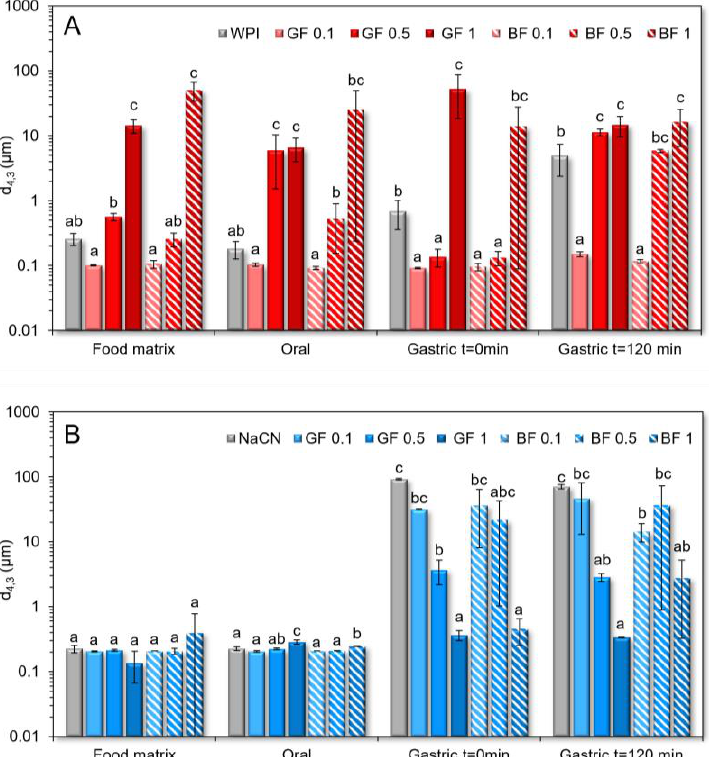
Figure 4. Changes in the protein aggregate particle size as they occurred throughout the simulated in vitro oro-gastrointestinal processing of the WPI-( A ) and NaCN-( B ) based food models. a–c Different letters between the bar phases denote a significant difference among the samples differing in the amount of gum for the same digestive.